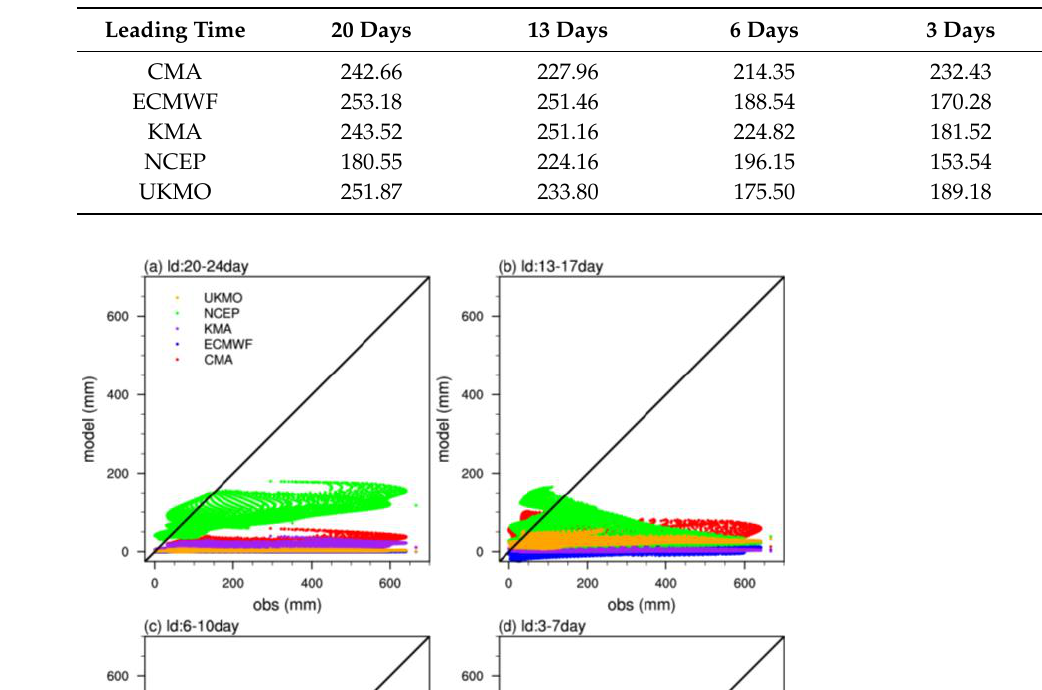
Table 4. RMSE of cumulative rainfall prediction during 18–22 July in Henan.